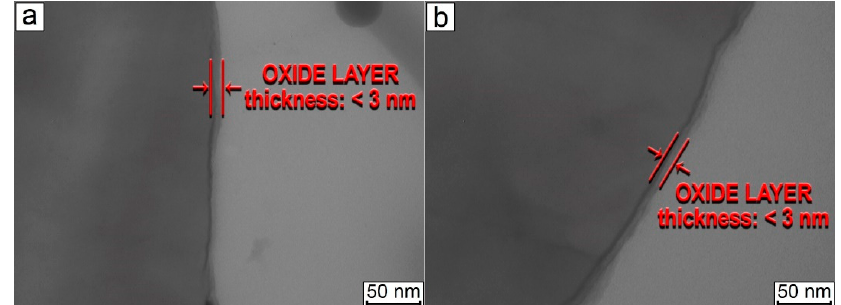
Figure 9. TEM images of ASP-30 powder: ( a ) before electrostatic classification; ( b ) after electrostatic classification with 30 kV voltage applied .